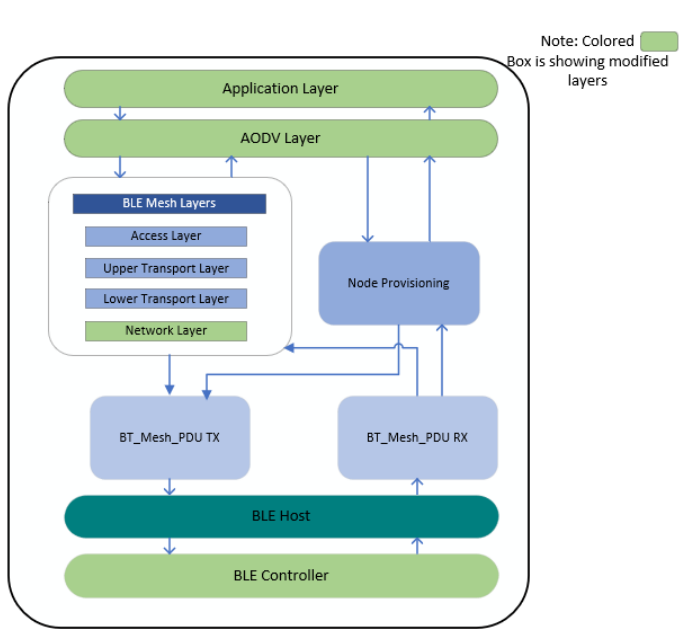
Figure 6. Message passing diagram with the AODV